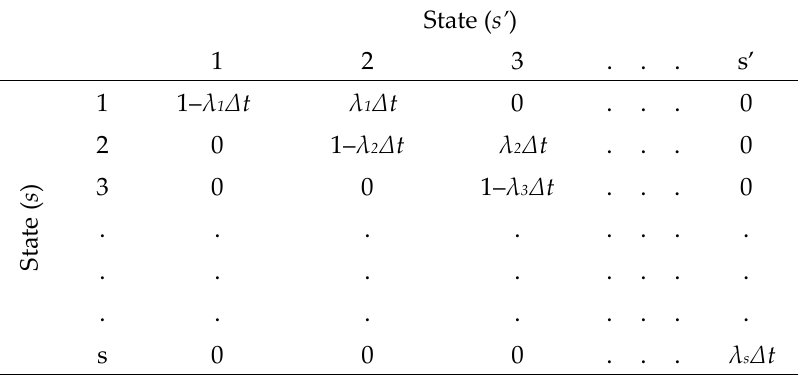
Figure 1. Initial transition probability matrix .